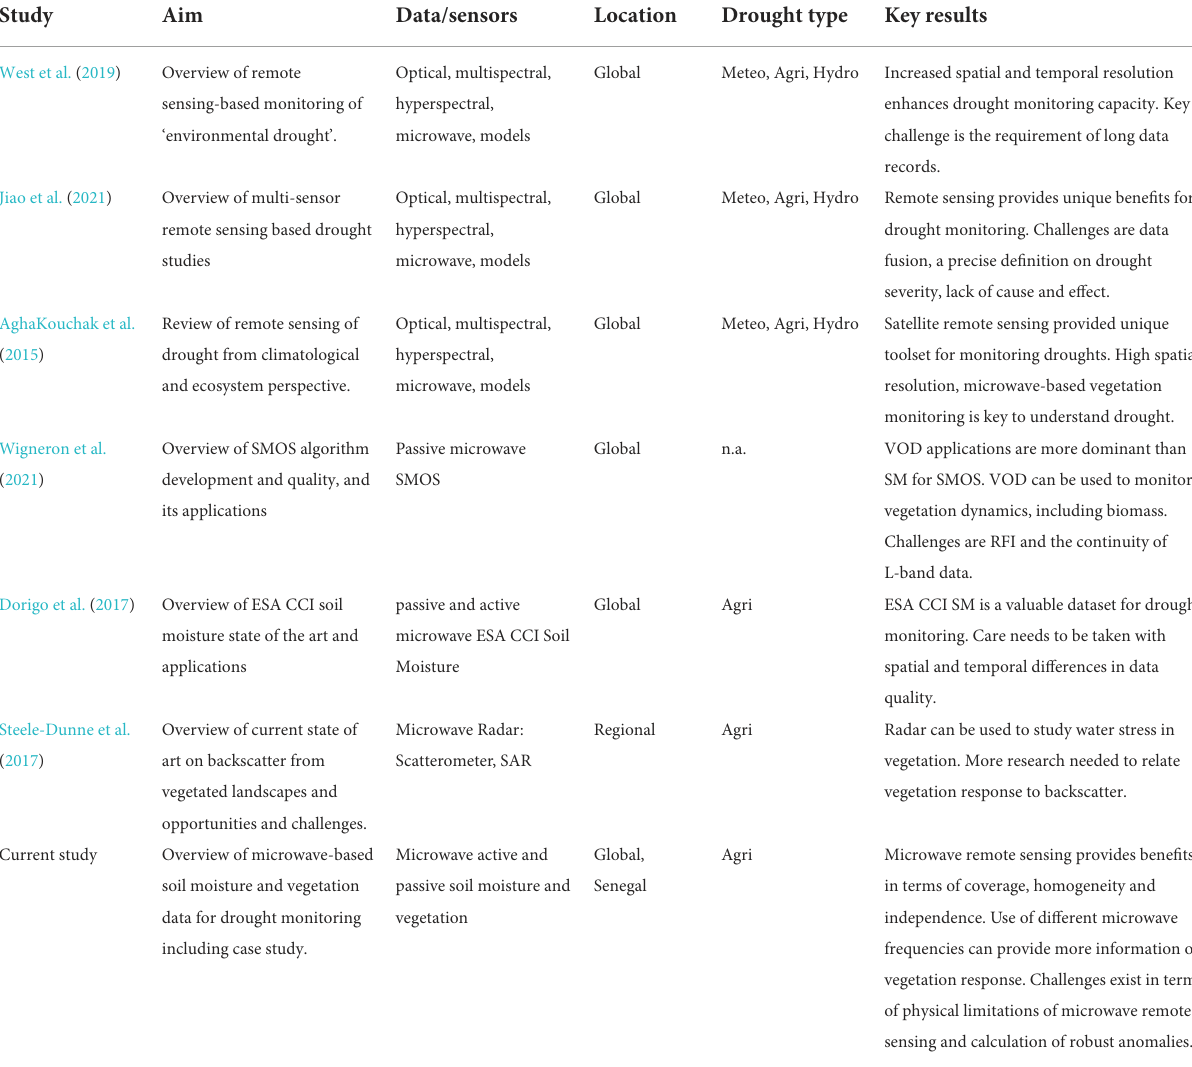
TABLE 1 Summary of relevant review papers on drought monitoring with remote sensing